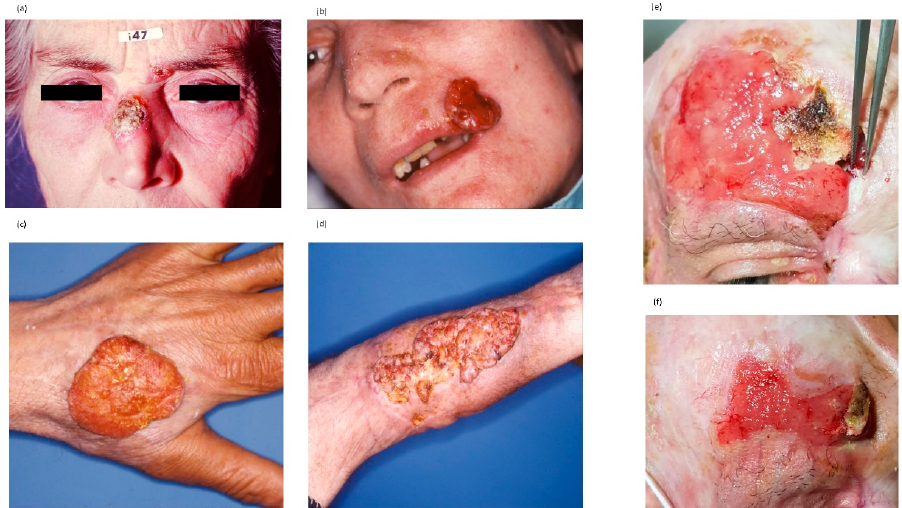
Figure 3. Clinical features of SSCs. Panels are representative of clinical presentation and response to immunotherapy: ( a ) SCC of the nose that arises on photo-damaged skin in presence of actinic keratosis of the left eyebrow; ( b ) high grade SCC of the left commissura of the lower lip; ( c ) SCC of the hand in patients in active treatment for concomitant LLC; ( d ) SCC originated on previous burned skin; and ( e , f ) effect of six-months course of anti-PD-1 MoAb in a patient with locally advanced SCC unfit for further surgery.